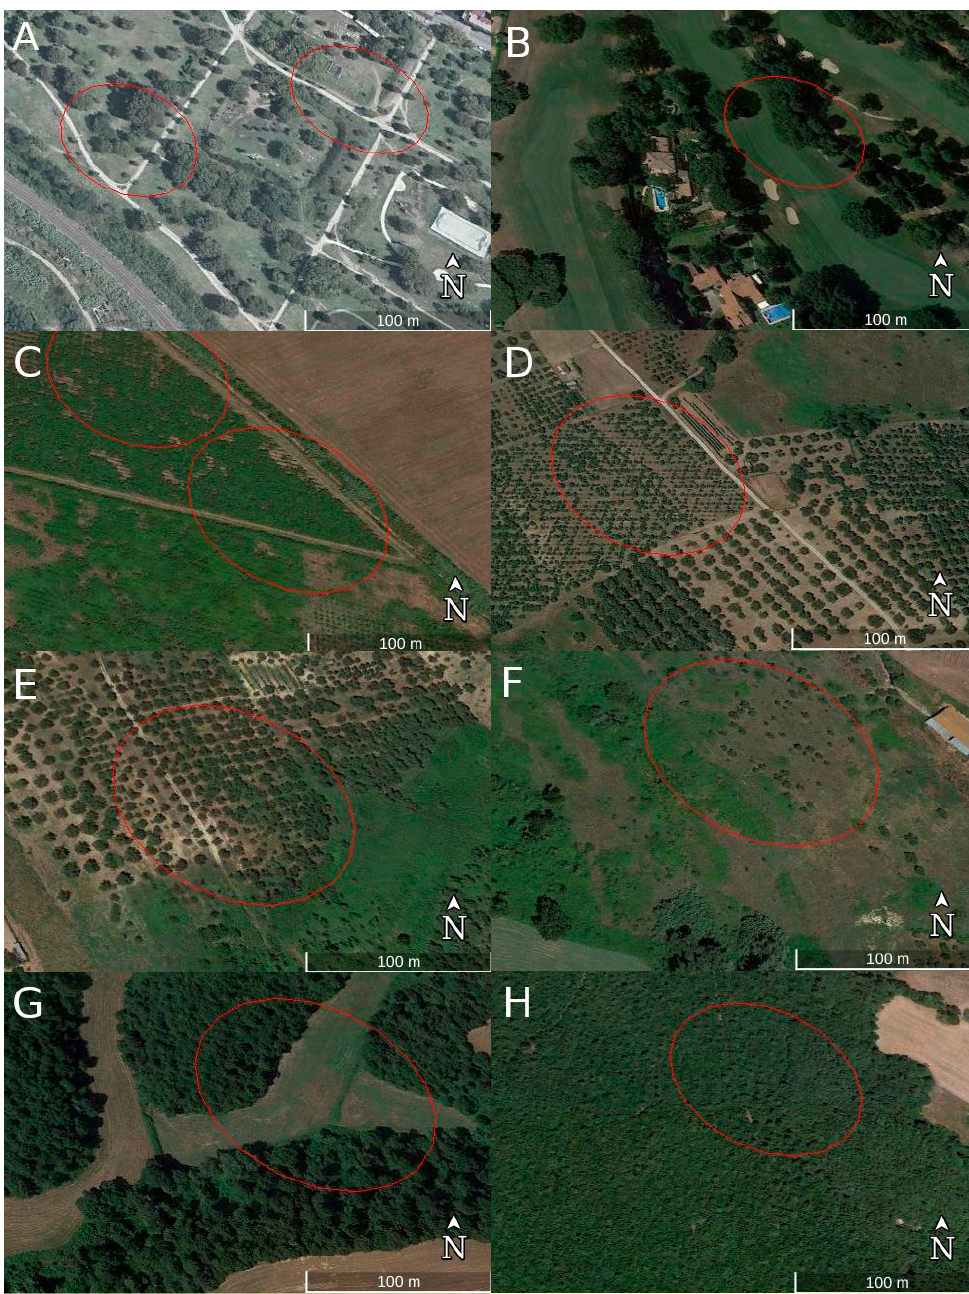
Figure 6. Sample plots drawn over the satellite view in Google Earth in various CLC classes. ( A ) 1.4.1 Green urban areas; ( B ) 1.4.2 Sport and leisure facilities; ( C ) 2.2.1 Vineyards; ( D ) 2.2.2 Fruit trees and berry plantations; ( E ) 2.2.3 Olive groves; ( F ) 2.4.2 Complex cultivation patterns; ( G ) 2.4.3 Land principally occupied by agriculture use; ( H ) 3.1.1 Broad-leaved forests.